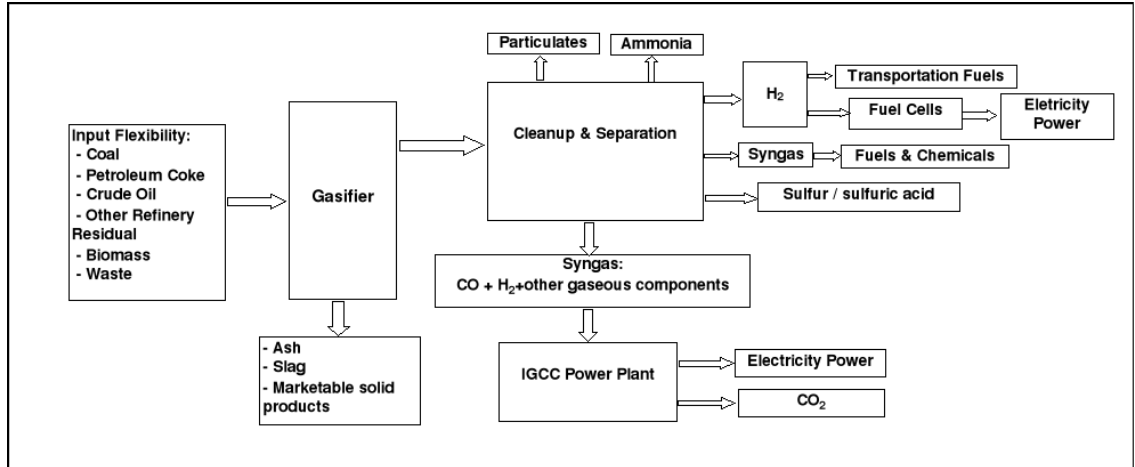
Figure 1. Input and output flexibility in gasification